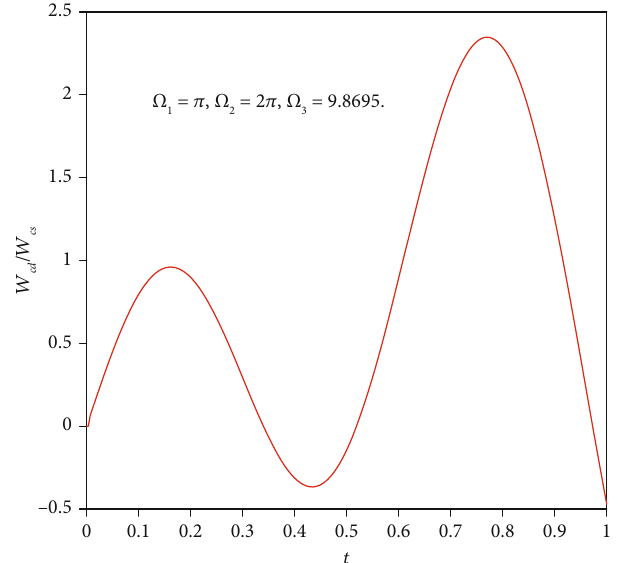
Figure 12: Numerical results for normalized central de fl ection of C-F beam excited by three actuators with excitation harmonic di ff erent.